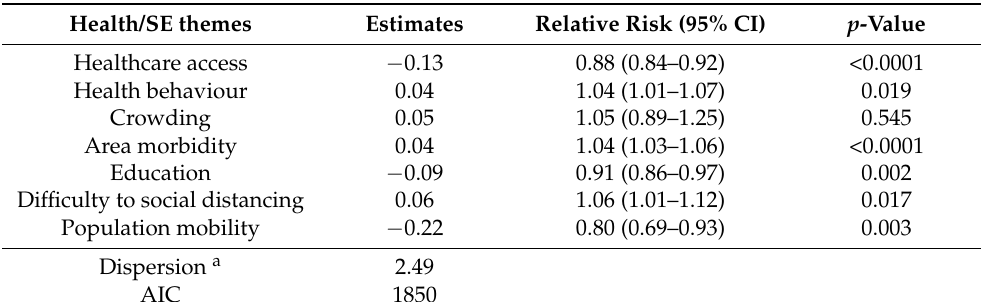
Table 1. Parameter estimates and 95% CI of the relative risk of COVID-19 associated with health